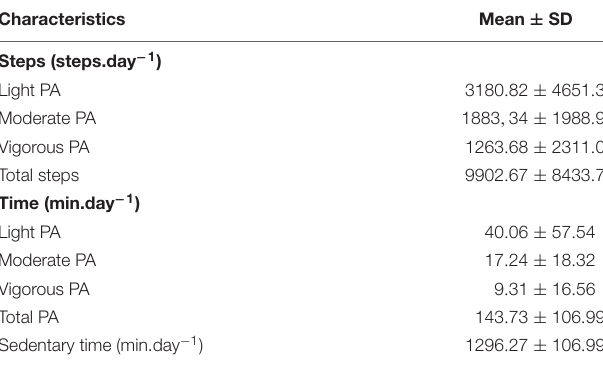
TABLE 4 | Descriptive PA data obtained from Xiaomi Mi Band 2 R (cid:13) ( n =